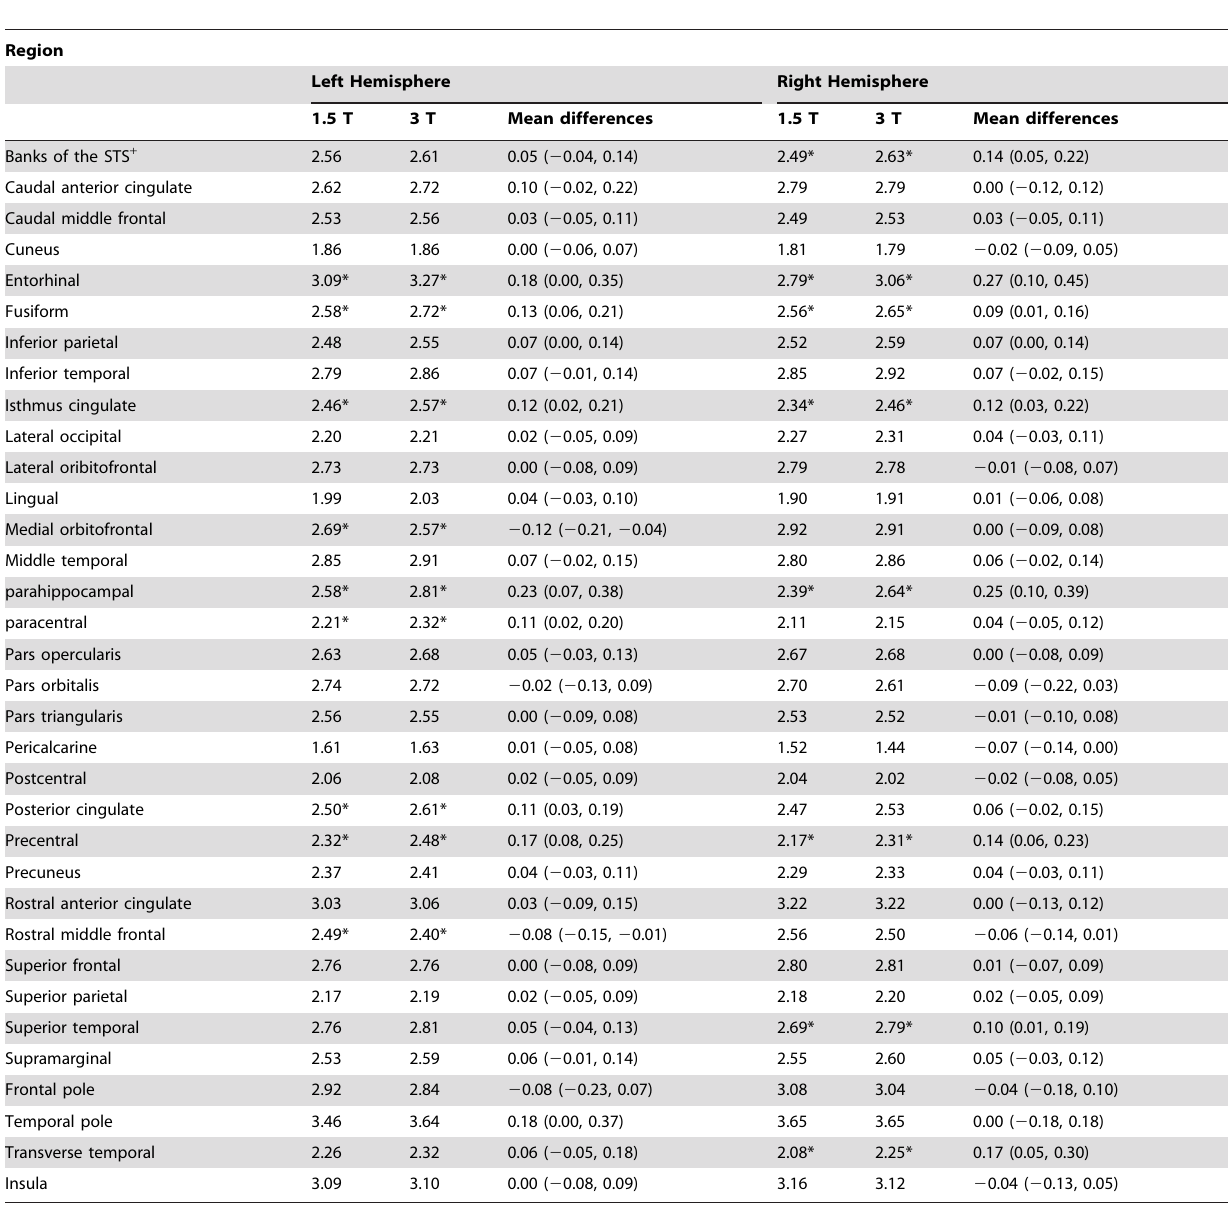
Table 8. Adjusted means and mean differences (95% confidence interval) of regional cortical thickness between 1.5 T and 3 T for males in the age group 20–40 after controlling for confounding